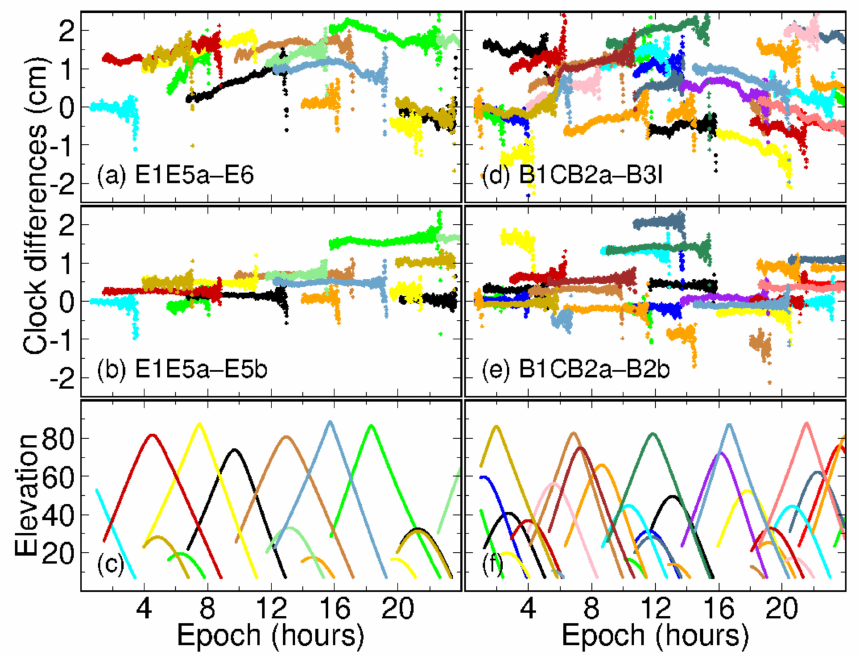
Figure 8. Clock differences between legacy satellite L1/L2 clock and the clock on the third- frequency L3. Panels ( a , b ) denote the results of Galileo E1/E5a/E6 and E1/E5a/E5b, while panel ( c ) gives the elevation angles of Galileo satellites at stations WTZZ. Panels ( d – f ) are the results for BeiDou-3